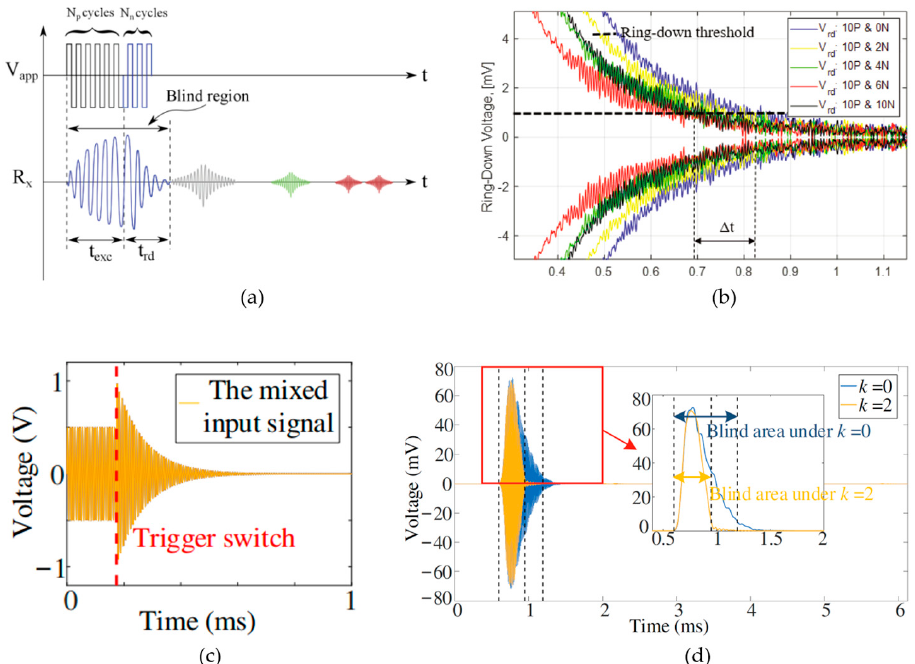
Figure 15. ( a ) Illustration of the 180 ◦ phase-shift ring-down suppression method [108]. Reproduced with permission from [108], Copyright 2021, IEEE. ( b ) The comparison experiment before and after suppression in [108]. Reproduced with permission from [108], Copyright 2021, IEEE. ( c ) The suppression signal of the ring-down suppression method is in [107]. Reproduced with permission from [107], Copyright 2021, MDPI AG. ( d ) The comparison experiment before and after suppression in [107]. Reproduced with permission from [107], Copyright 2021, MDPI